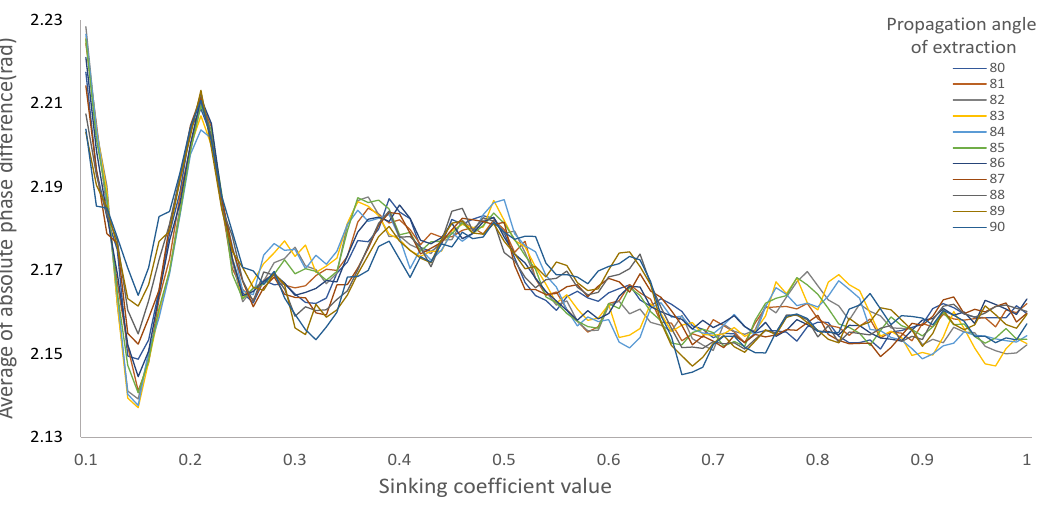
Figure 8. Parameter variation